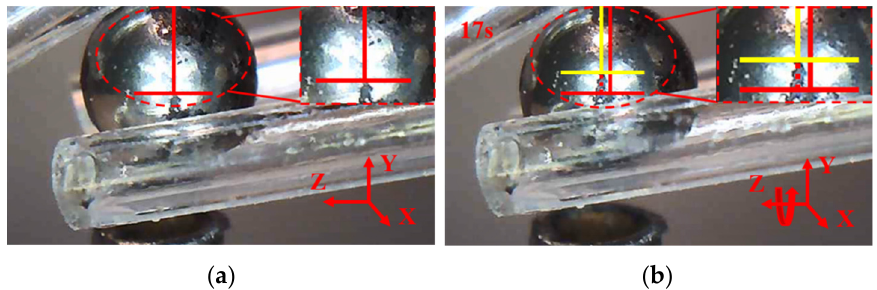
Figure 19. The micro ball is rotated about axis Y. ( a ) the micro ball is moved to a distance; ( b ) the micro ball is rotated about axis Y.